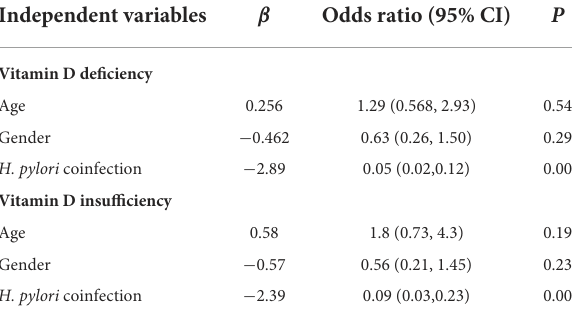
TABLE 3 Models derived with multivariate logistic regression analysis of associated factors of vitamin D deficiency and